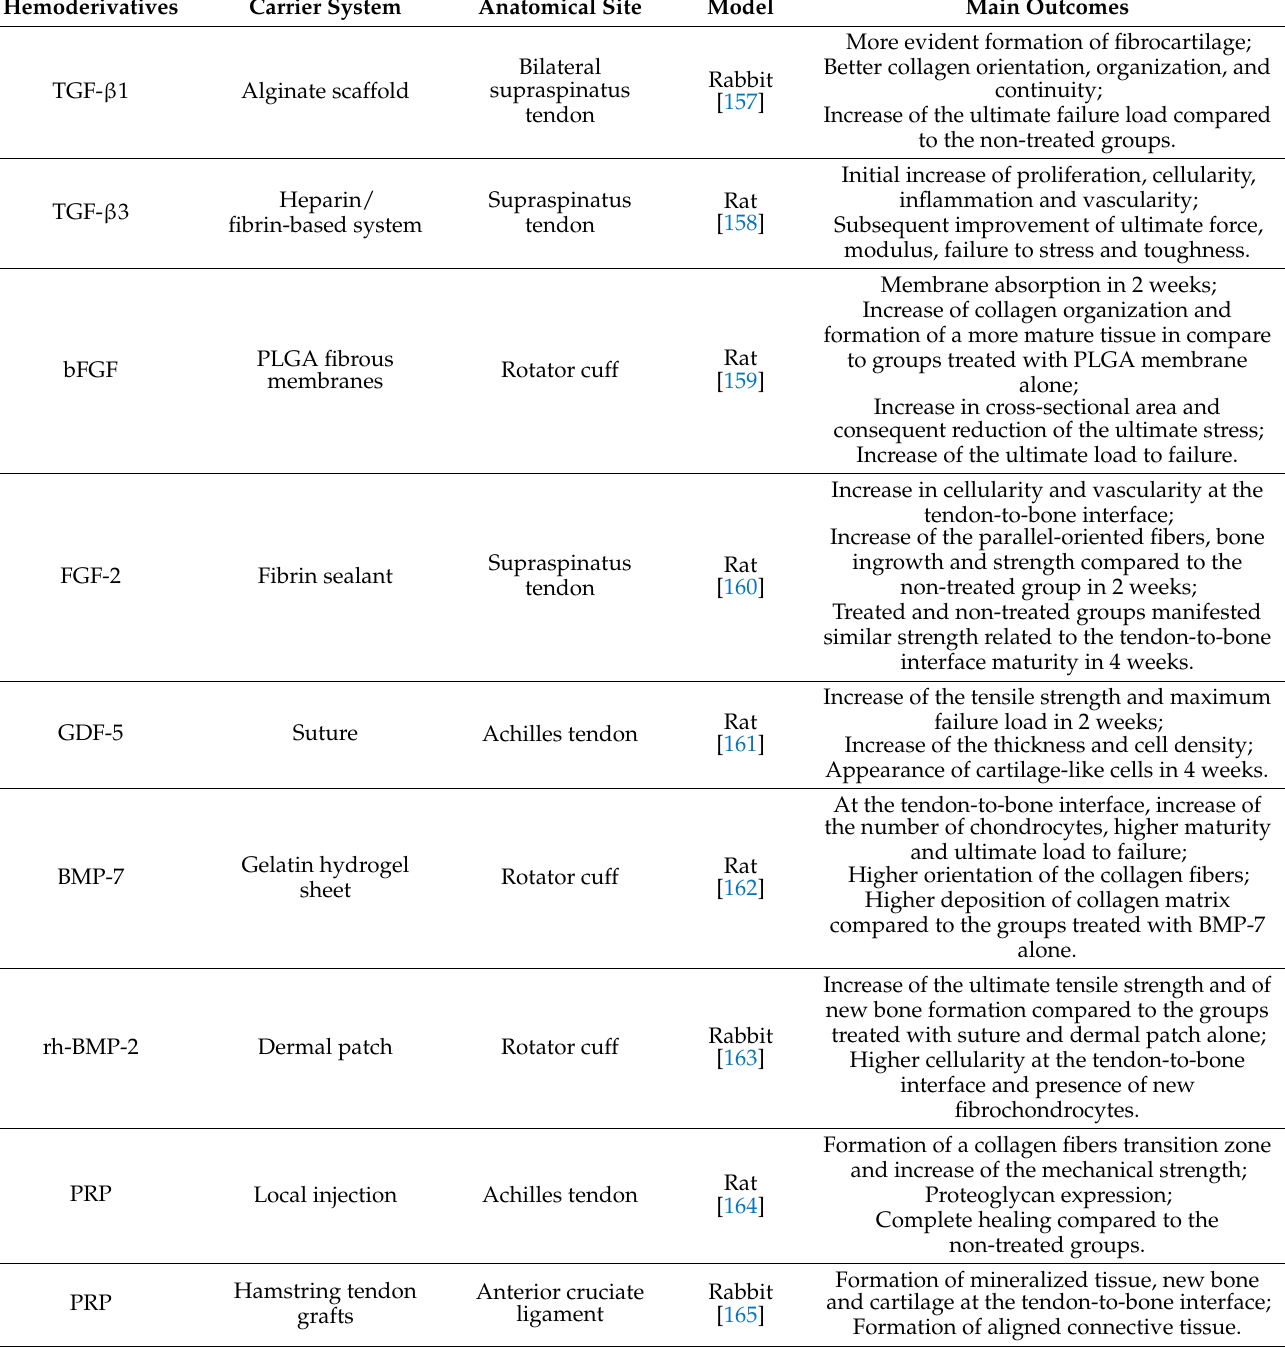
Table 1. In vivo studies using growth factors (GFs) and blood derivatives for tendon